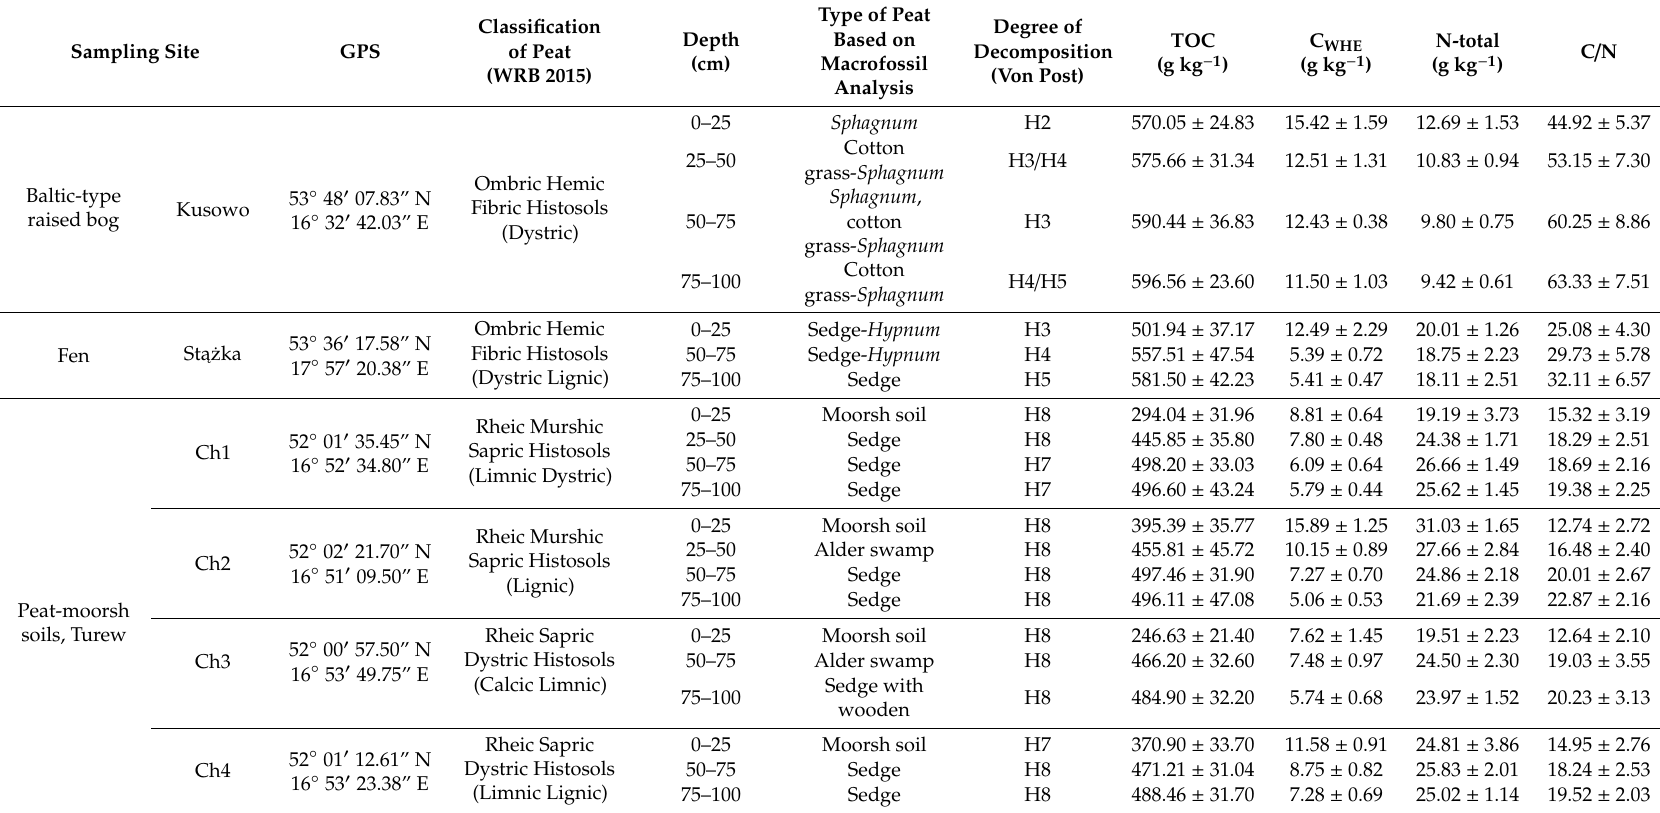
Table 1. The classification of peat (WRB 2015), type of peat, degree of decomposition, and chemical properties of peat soils.